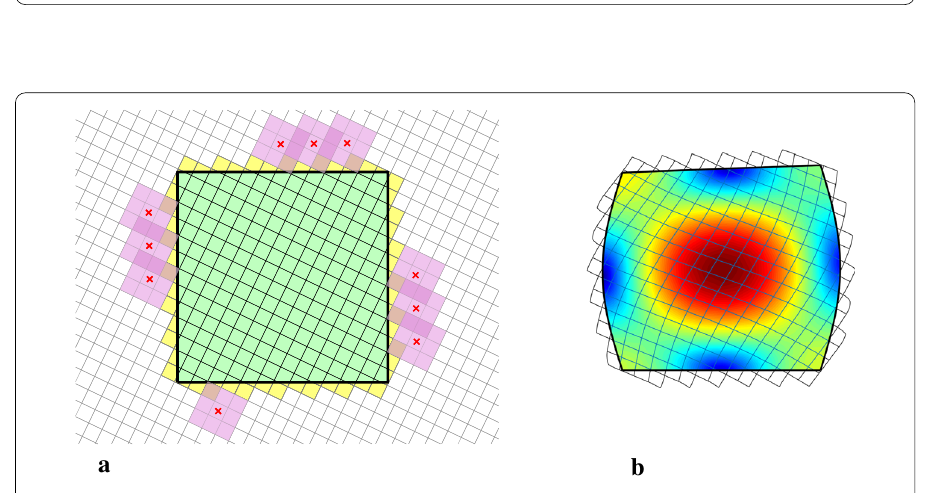
Fig. 9 Example of numerical solution using C 1 Q 2 splines and mesh size h = 0 . 1. The mesh is rotated π/ 7 radians to induce cut situations and the removed basis functions are selected using the tolerance √ E . a Mesh and removed spline basis functions. b Numerical solution tol = 0 . 01 h 2 ×